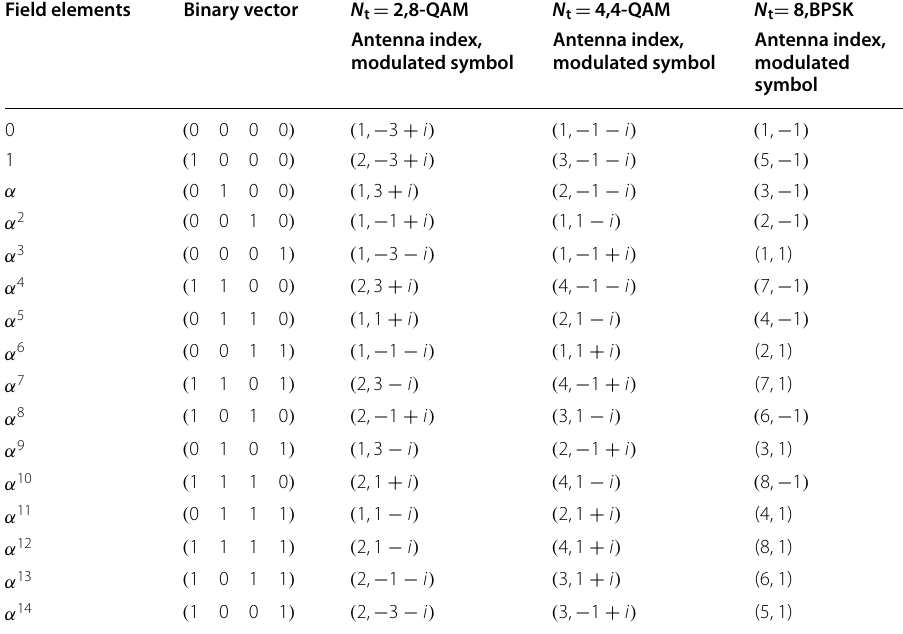
Table 1 Different mapping results of SM scheme with code over GF( 2 4 ) Field elements Binary